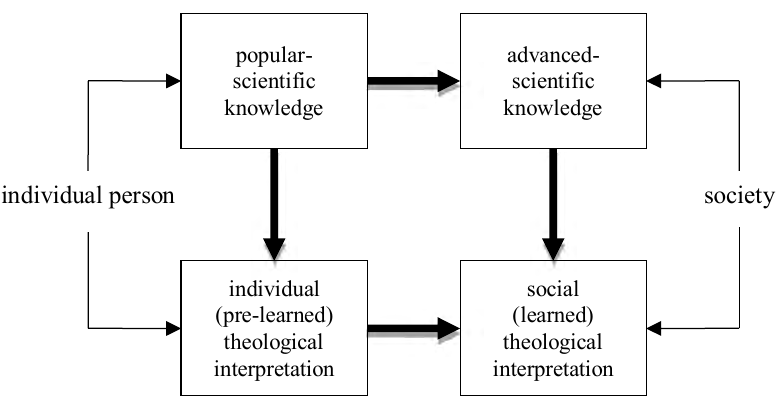
Figure 2: Series-parallel structure of the system epistemology of miracle We refer to the feedback between two systems, when at least one external output of the first system is at the same time the external input of the second system and when at least one external output of the second system is at the same time the external input of the first system. The special case of feedback is the self-join. It involves the situation, in which the system both receives the action from itself and exerts the action on